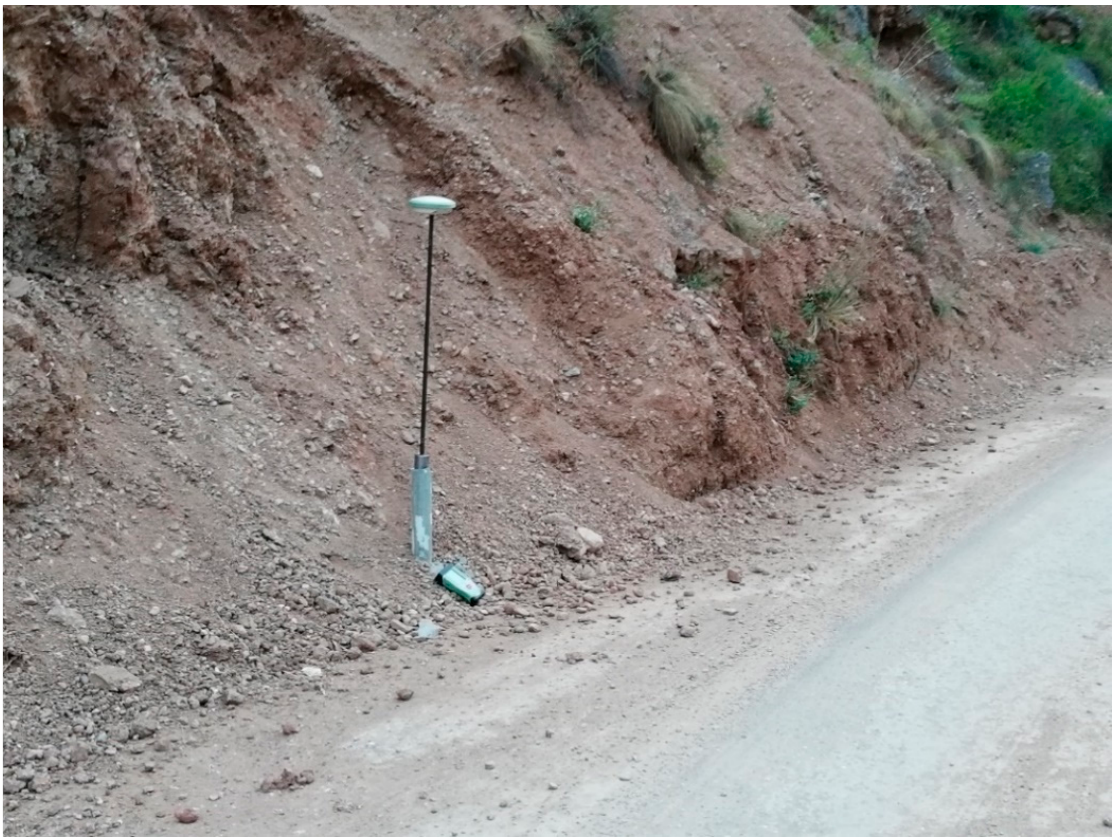
Figure 4. Permanent location on the road area for the execution of GNSS measurements.